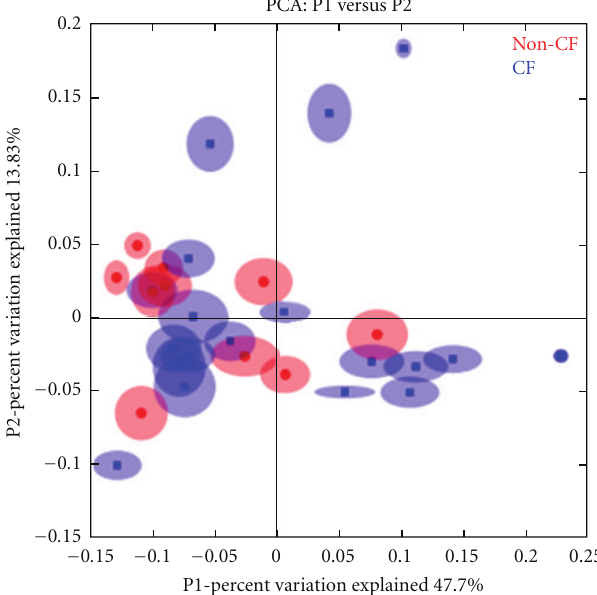
Figure 4: Principal components analysis (PCA) of bronchiectasis (red) and CF patients